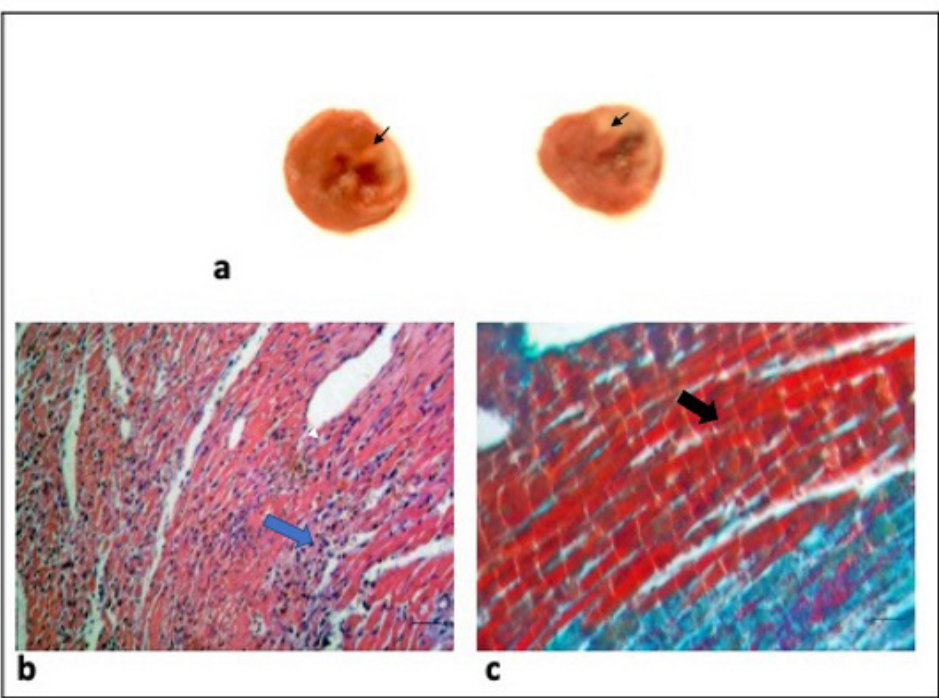
Fig. 1. Representative heart images and histological features of the heart in HF groups (200 × ) . (a) The infarct area was located in the anterolateral region of the left ventricular anterior wall and was extended from the subendocardial region to the endocardium (black arrow); (b) Congestion, focal necrosis with inflammatory cell infiltration in HE stained slices (blue arrow); (c) Necrosis characterized by contraction bands linked by muscle fiber bridges and haemorrhage between them in MS-stained slices (black arrow).